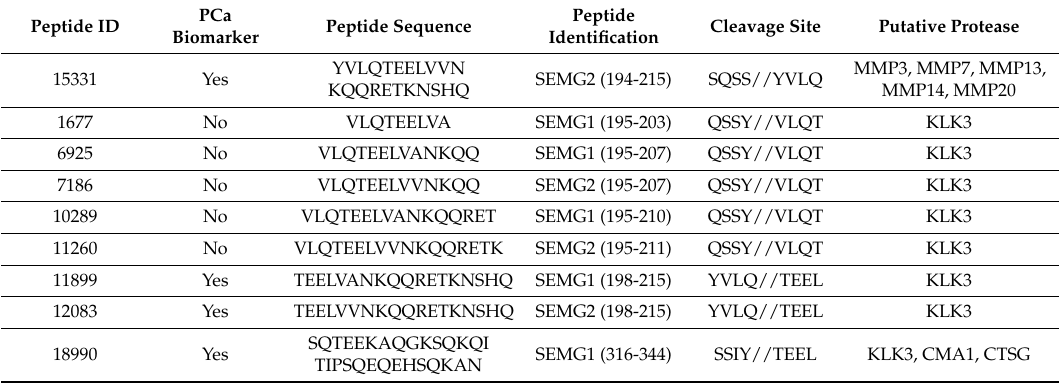
Table 1. Semenogelin derived seminal peptides and their putative proteolytic cleavage sites.